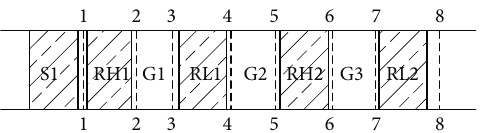
Figure 2: Schematic diagram of a staggered counter-rotating turbine.